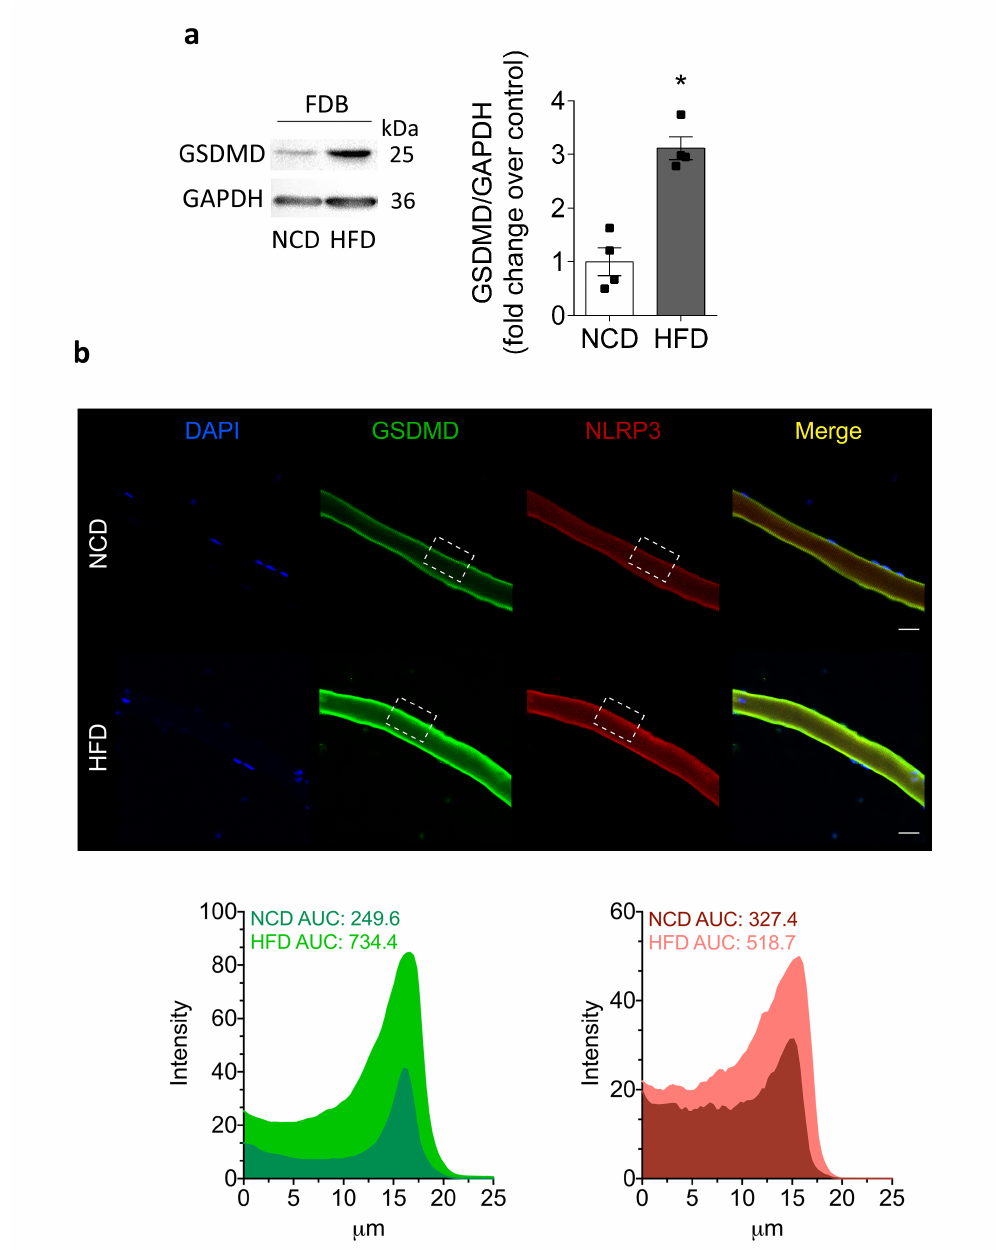
Figure 6. Cleaved GSDMD increases in HFD-fed mice. We dissected and homogenized FDB muscles from NCD- or HFD-fed mice and assessed the GSDMD level by Western blot. We also studied GSDMD subcellular location in fixed isolated fibers by immunofluorescence. ( a ) Representative Western blot and quantification showing cleaved GSDMD; 60 µ g of lysate was loaded in each lane. The GSDMD bands were observed at 25 kDa. Values represent the mean ± SEM ( n = 4). * p < 0.05, determined by Student’s t -test. ( b ) Representative confocal images of isolated adult FDB fibers from NCD- and HFD-fed mice illustrating the localization of GSDMD (green) and NLRP3 (red). DAPI staining of the nuclei is shown in blue. The area under the curve (AUC) was measured on white squares, and represented as fluorescence intensity. Scale bar: 20 µ